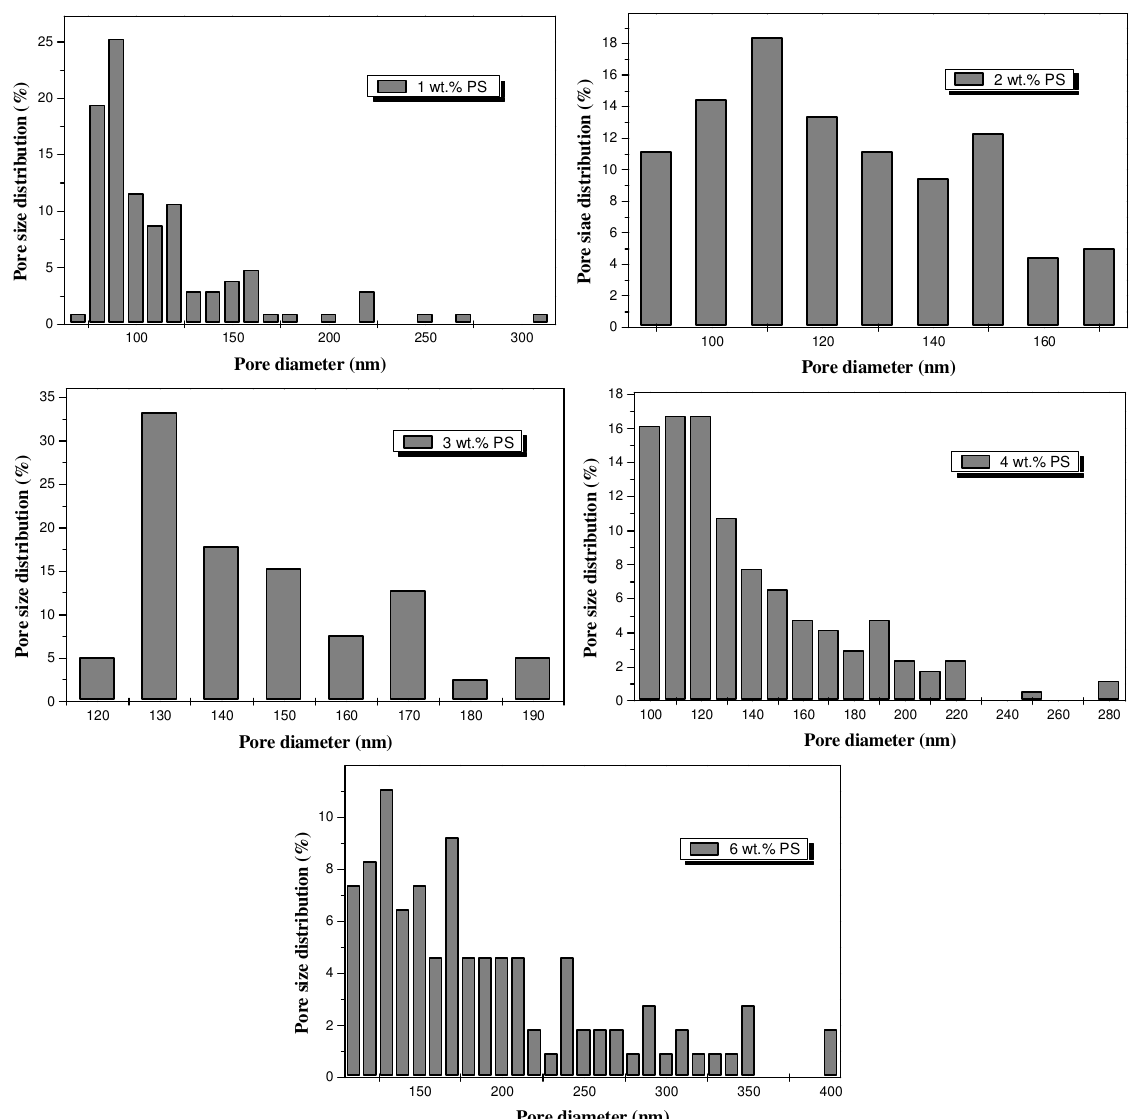
Fig. 6. Pore size distributions of the outer surface of the hollow fiber blend